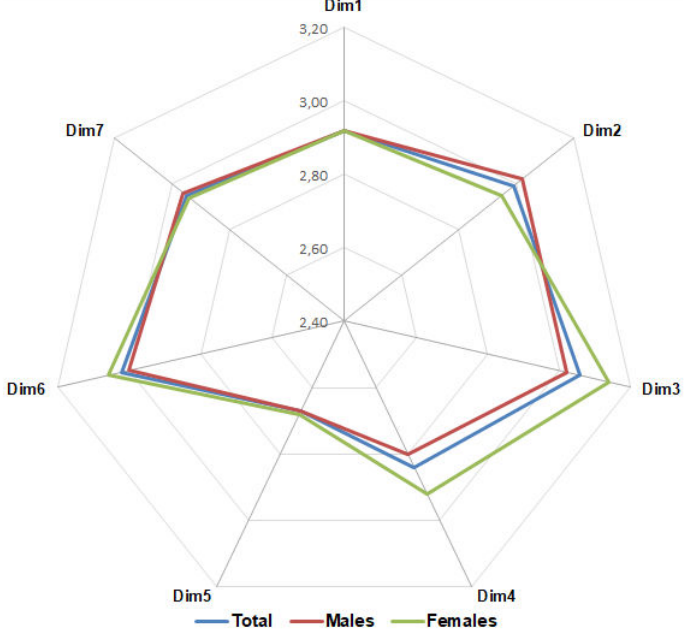
Figure 5. Overall scores obtained by males and females compared to the total values obtained by the interviewed